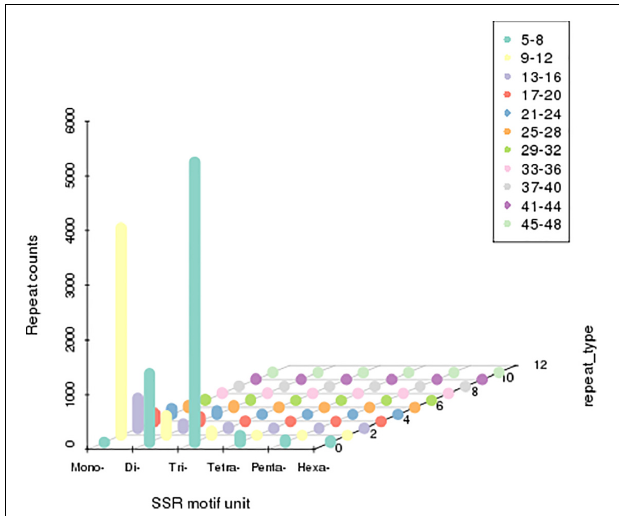
FIGURE 4 | Distribution of simple sequence repeats (SSRs). The X-axis represents the type of SSRs. Z-axis represents the number of SSRs. The numerical value of the Y-axis is coordinate. The number of specific repeats is in accordance with colored illustrations.